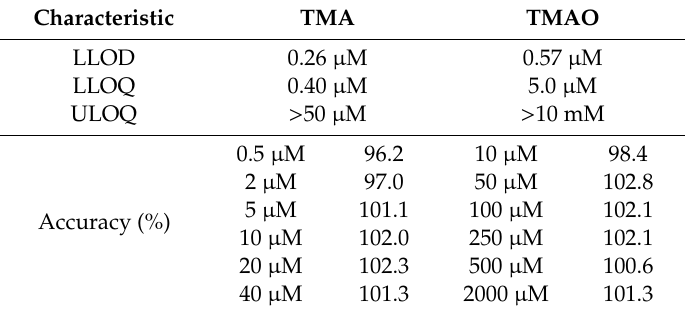
Table 1. Characteristics of the method for the TMAO and the TMA determination by LC / MS / MS.